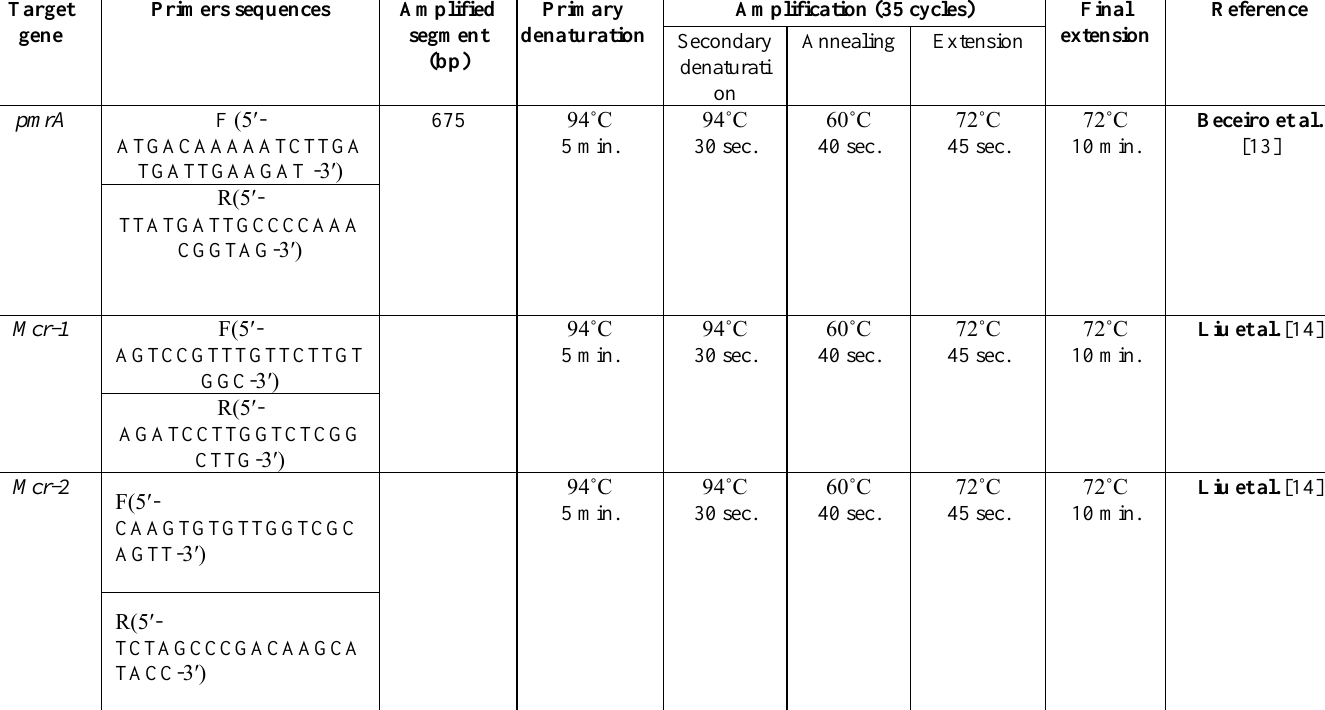
Table 1. Primers sequences, target genes, amplicon sizes and cycling conditions.